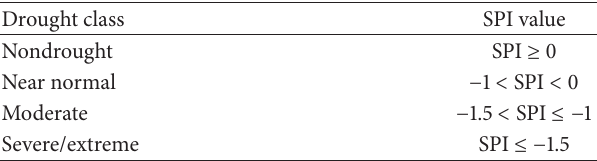
Table 2: Drought classification of